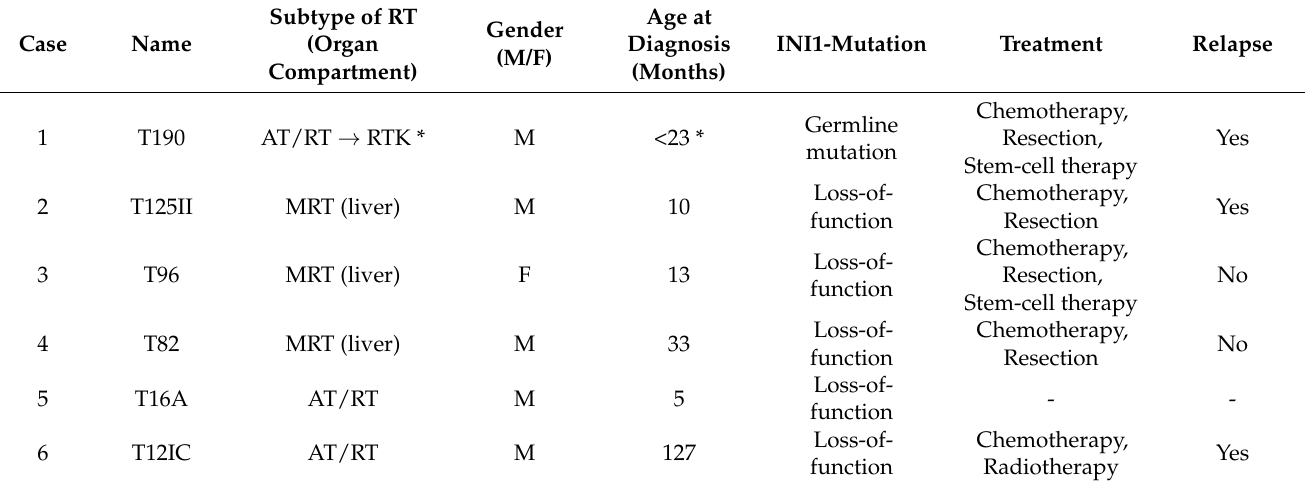
Table 2. Summary of the characteristics of tumor samples.